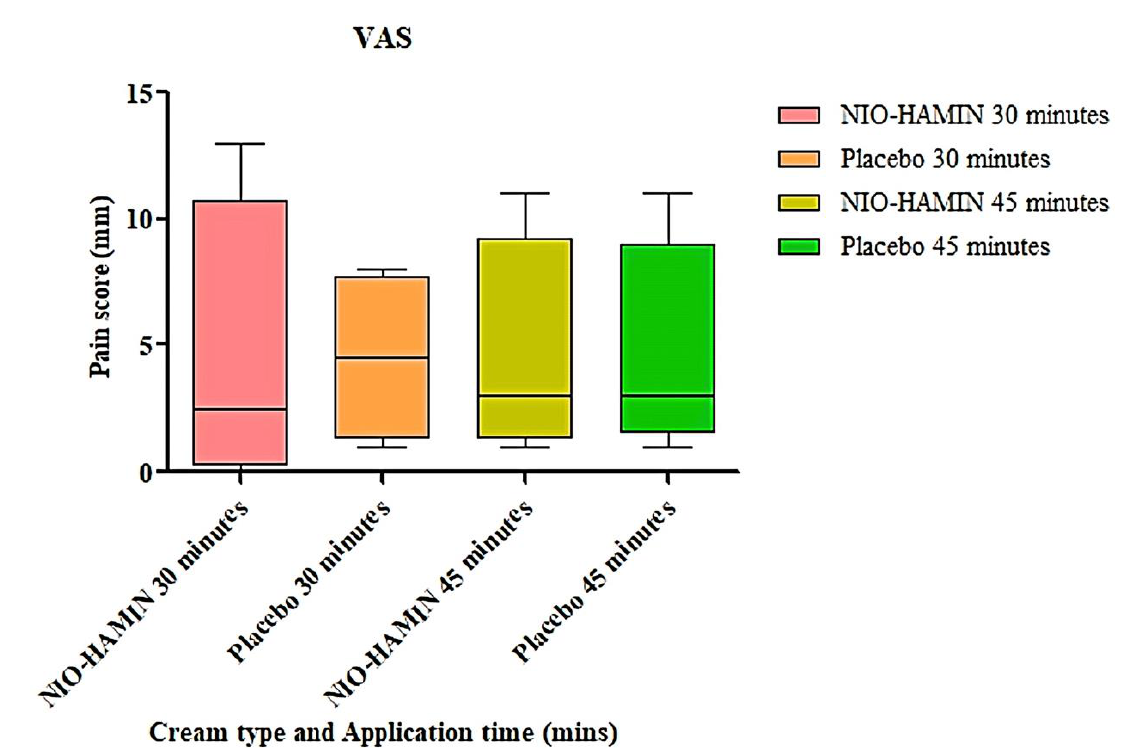
Figure 8. Visual analogue score (VAS) for NIO-HAMIN F1-C emulgel compared to placebo. Values are presented as pain score vs. treatment ( n = 20, p < 0.05).